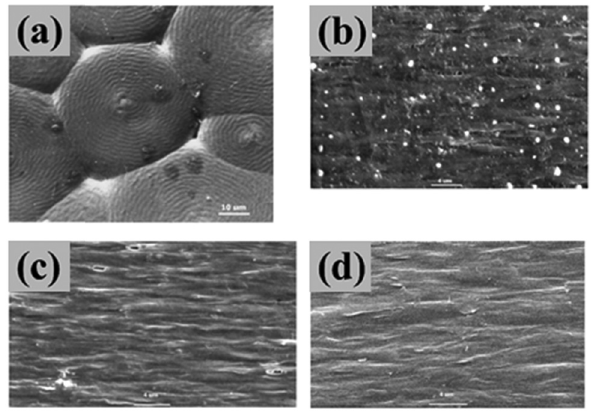
Figure 11: SEM ( scanning electron microscopy ) micrographs obtained from samples stretched with di ff erent elongation ratios at 80°C: ( a ) 1; ( b ) 2; ( c ) 3; and ( d ) 4 [ 104